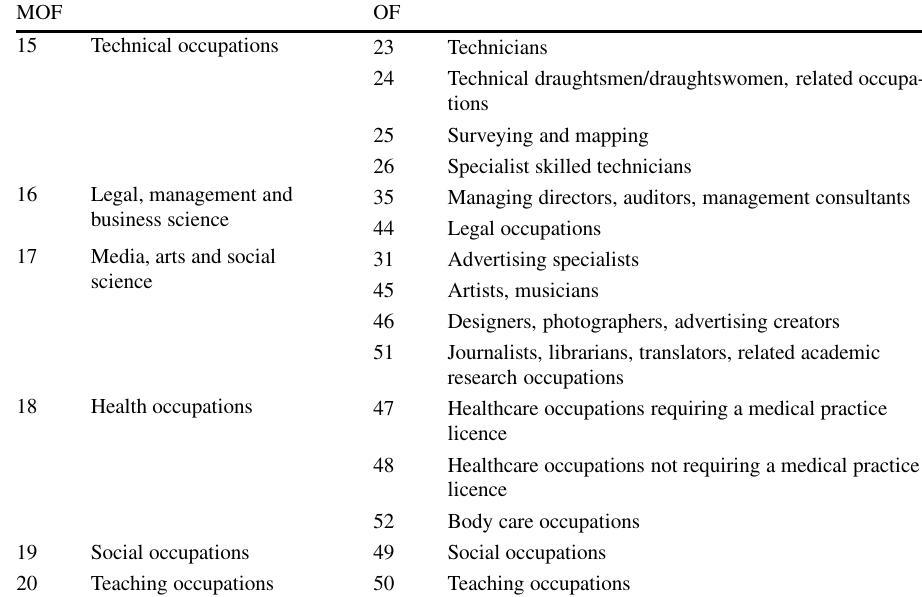
Fields (MOF) and Occupational Fields (OF) (Continued)